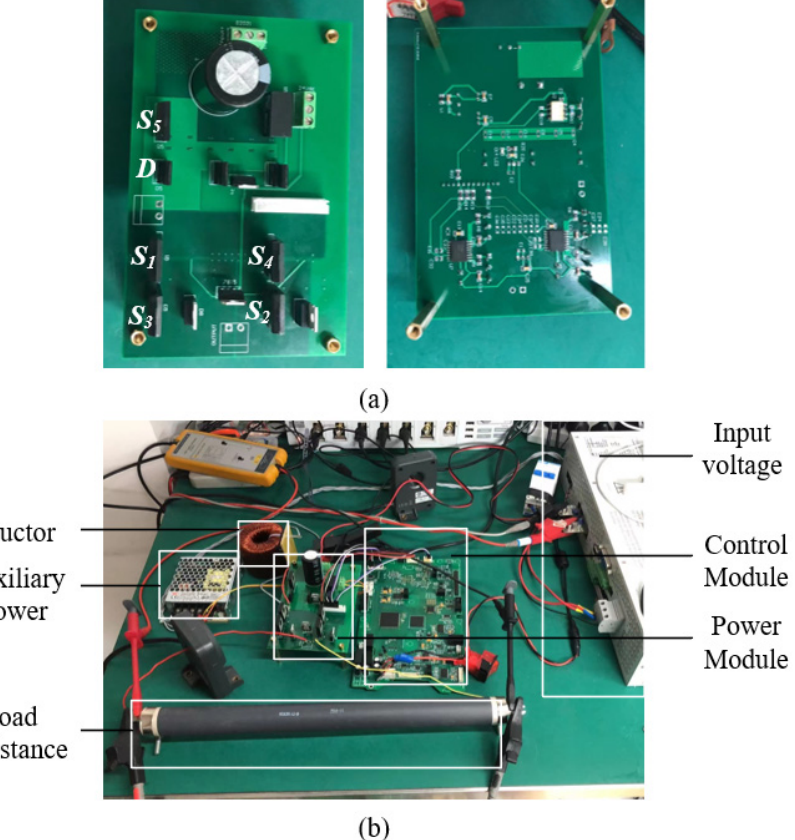
Figure 18. Photograph of the CSI and the testing platform: ( a ) power module of CSI; ( b ) efficiency testing platform.